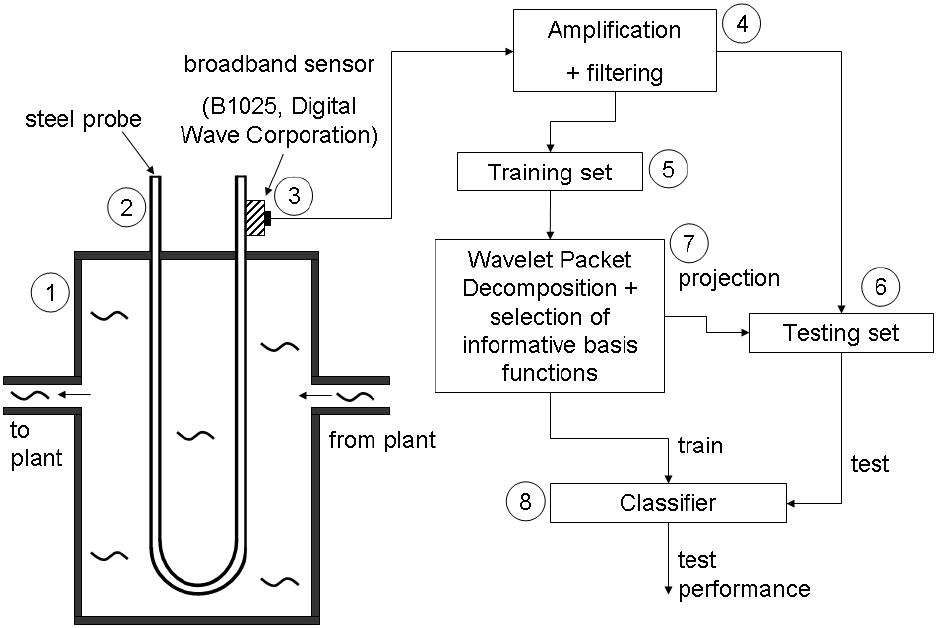
Figure 1. Processing stages for making predictions of the corrosion type. A steel probe (2) is inserted in a bypass (1) of the chemical process plant and is therefore exposed to the same environmental conditions as the installation. Acoustic events are captured by means of a broadband sensor (3). Subsequently AE signals are amplified and filtered (4). In order to obtain a fair validation of the system, the acquired signals are split into a training (5) and testing set (6). Features are extracted from the training signals by means of a Wavelet Packet Decomposition (7). A classifier (8) is trained based on the selected wavelet coefficients of the training set. Testing signals are projected onto the selected basis functions. Subsequently, the wavelet coefficients of the testing signals are used to test the overall performance of the